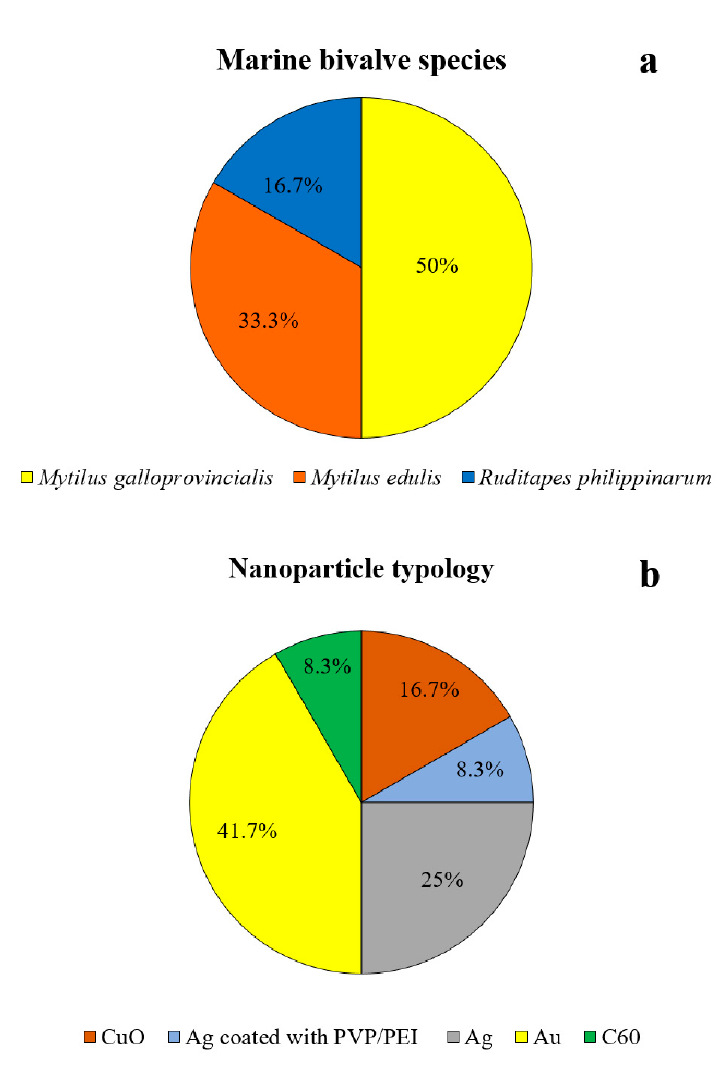
Figure 1. Percentage of proteomic studies performed on different bivalve species ( a ) and different nanoparticles ( b ) to investigate changes in protein profile. Au = gold nanoparticles; Ag = silver nanoparticles; PVP/PEI = Poly N-vinyl-2-pirrolidone/Polyethyleneimine; CuO = copper oxide nanoparticles; C 60 = fullerene nanoparticles.